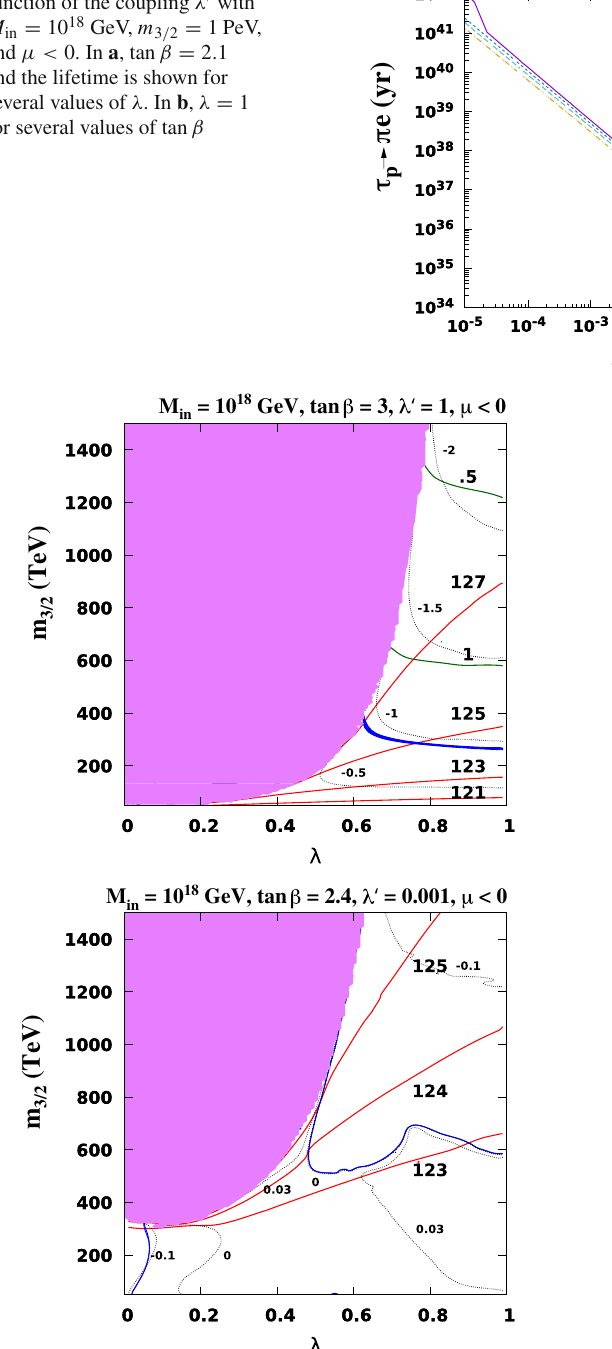
Fig. 7 Examples of the λ - m 3 / 2 plane for M in = 10 18 GeV, and μ < 0. In the upper panel, tan β = 3 with λ (cid:7) = 1, and in the lower panel, tan β = 2 . 4 with λ (cid:7) = 0 . 001, The solid red and dotted black curves show the Higgs mass m h and c , respectively. The solid green contours in the upper panel show the value of the proton lifetime in units of 10 35 years. The blue shaded region corresponds to the areas where the LSP abundance agrees to the observed dark matter density. In the magenta region, we do not have successful